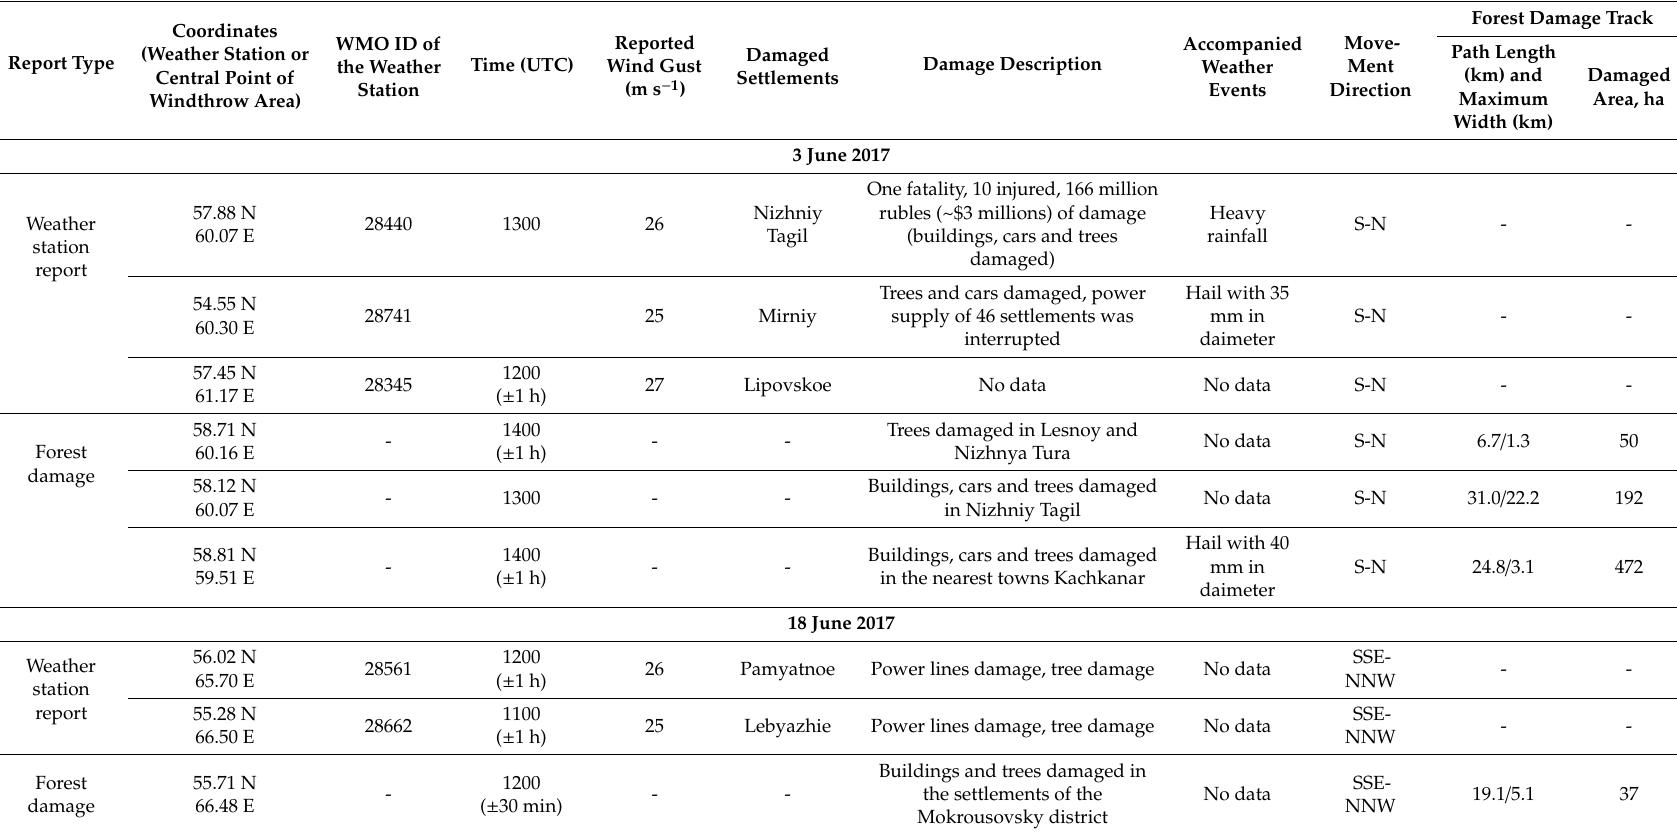
Table A3. List of strong squall events (reported at the weather stations or caused forest damage) occurred on 3 June 2017 and 18 June 2017.